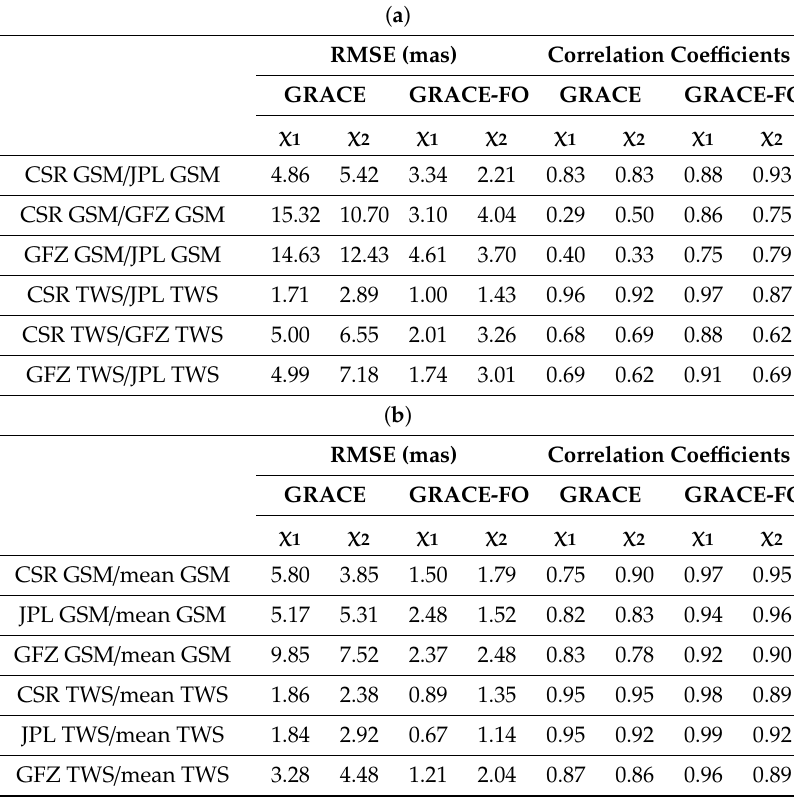
Table 1. ( a ) Root mean square (RMS) of di ff erences (root-mean-square errors, RMSE) and correlation coe ffi cients between HAM / CAM from particular GRACE / GRACE-FO solutions and ( b ) RMSE between HAM / CAM from particular GRACE / GRACE-FO solutions and HAM / CAM from mean GRACE / GRACE-FO (mean of CSR, JPL, and GFZ solutions). Note that for GRACE, the critical value of correlation coe ffi cient for 58 independent points and a 95% confidence level is 0.22, while the standard error of the di ff erence between two correlation coe ffi cients is 0.19. For GRACE-FO, the critical value of correlation coe ffi cient for 12 independent points and a 95% confidence level is 0.50, while the standard error of the di ff erence between two correlation coe ffi cients is